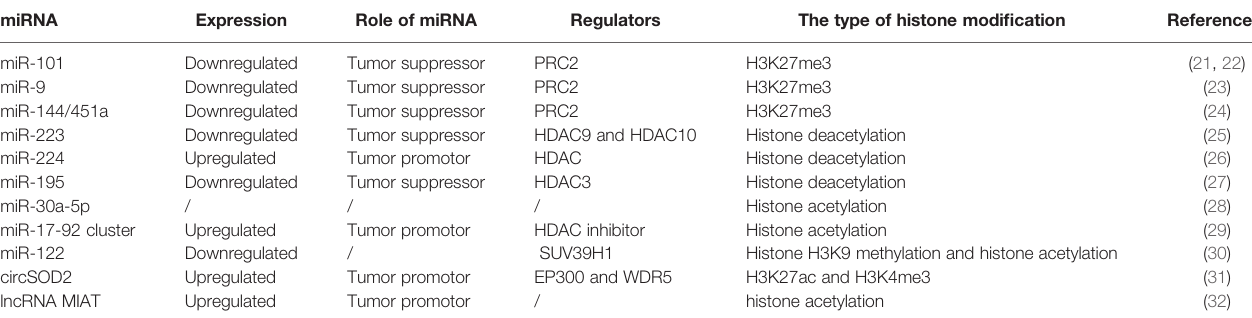
TABLE 1 | Oncogenic or tumor suppressive ncRNAs is regulated by histone modi fi cation in HCC. miRNA